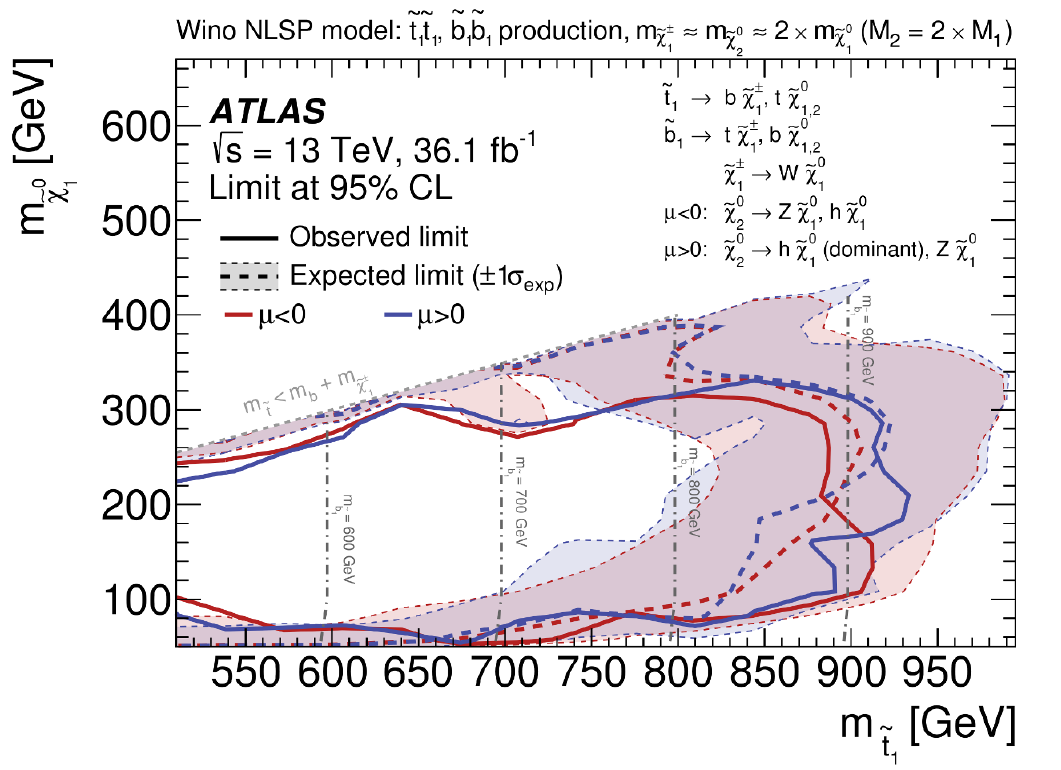
Figure 22 . Expected (dashed) and observed (solid) 95% excluded regions in the plane of m versus m ~ for direct stop/sbottom pair production in the wino NLSP model under the hypothesis t 1 of m q 3 L < m tR , where various decay modes (~ t and ~ b b ~ (cid:31) 0 2 ) are considered with di(cid:11)erent branching ratios for each signal point. The ~ (cid:31) 0 2 1 !